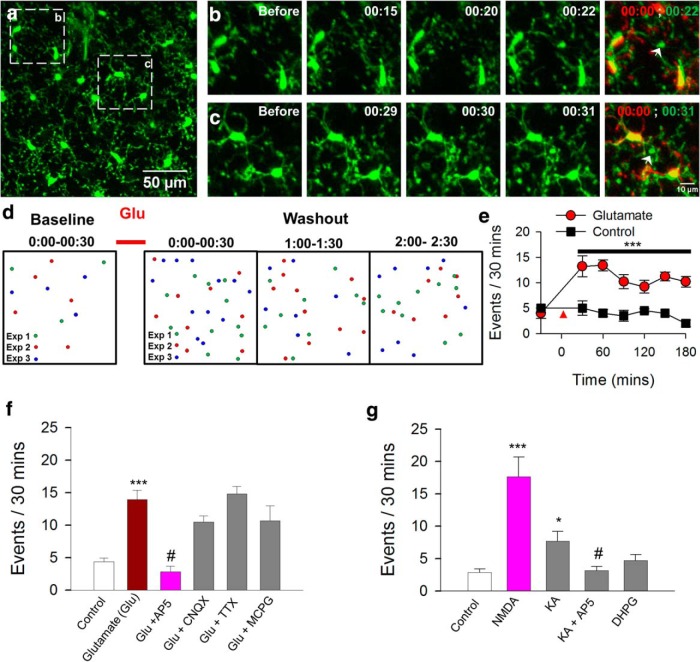
Transient glutamate treatment mimics seizure-induced MPCs. a–c, Images from a time-lapse sequence showing converging microglial processes in a slice after glutamate (10 mm) treatment for 10 min. b, c, Time-lapse images of boxed regions in a showing converging microglial processes foci identified with white arrows. d, e, Schematic of sites of process convergence events (d) and quantified summary (e) showing increased occurrence after glutamate treatment (red arrowhead in e, n = 3 slices each). f, g, Quantification of the number of process convergence events under different conditions showing a role for NMDA receptors (n = 5–14 slices each). *p < 0.05; ***p < 0.001 compared with control and #p < 0.01 compared with previous condition in the respective graphs.